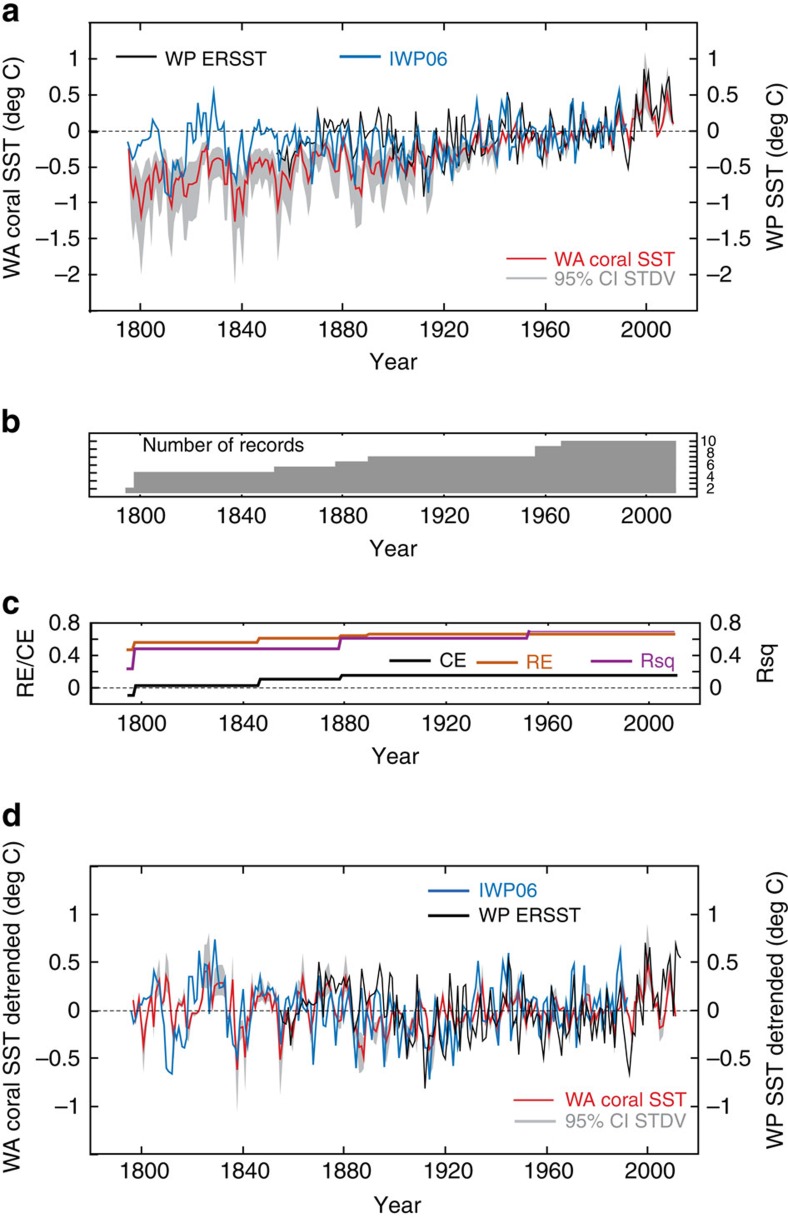
Southeast Indian Ocean coral SST anomaly reconstruction and Western Pacific SST anomalies.(a) Reconstructed annual WA coral SST anomaly (red) with 95% confidence interval (grey shaded) based on the spread of both coral and ERSST standard deviations between 1961 and 1990 compared with Indonesian warm pool26 (IWP06; blue) and WP SST anomaly reconstructions15 (WP ERSST; black). SST anomalies are relative to 1961–1990 mean, (b) Number of coral cores through time, (c) Reconstruction skill statistics for WA coral SST against regional ERSST15 (17–28° S, 113–119° E) are calculated over the validation period (1920–1949) for each proxy nest, including the coefficient of determination (Rsq, magenta), the reduction of error (RE, orange), and the coefficient of efficiency (CE, black) and (d) Same as a, but detrended time series.